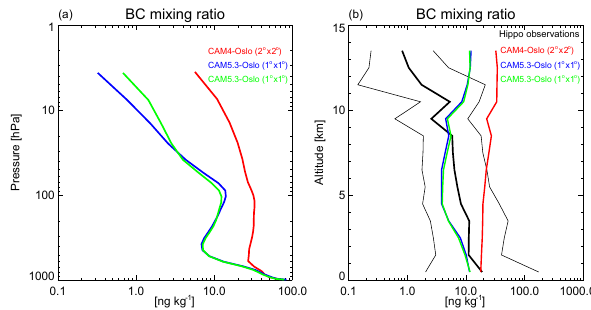
Figure 5. (a) Globally averaged annual BC mass mixing ratio pro- files as modeled in the NUDGE_PD (blue line) and AMIP_PD (green line) experiments and in CAM4-Oslo (red line) for compar- ison. (b) Modeled BC mass mixing ratio profiles from the same simulations as in (a) compared to HIPPO aircraft campaigns aver- aged over the areas and months in which the campaign took place (Schwarz et al., 2013; see also Samset et al.,